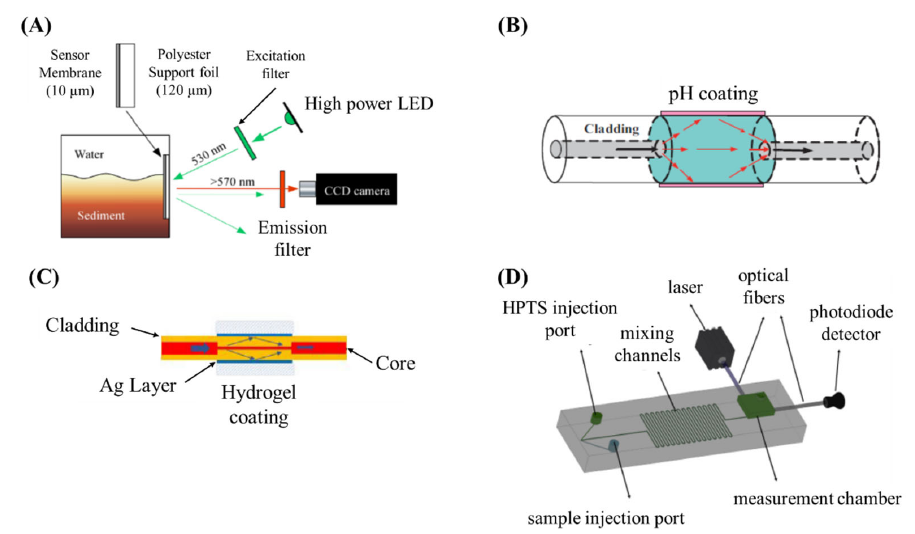
Figure 2. ( A ) Setup for spatial pH measurement of marine sediment (reprinted from [21] with the permission of Wiley). ( B ) Optical fiber without a core used for pH sensing (reprinted from [31] with the permission of Elsevier). ( C ) Hydrogel base fiber optic structure (reprinted from [39] with the permission of Elsevier). ( D ) Microfluidic device for pH measurements reported by Vahid et al. (reprinted from [40] with the permission of